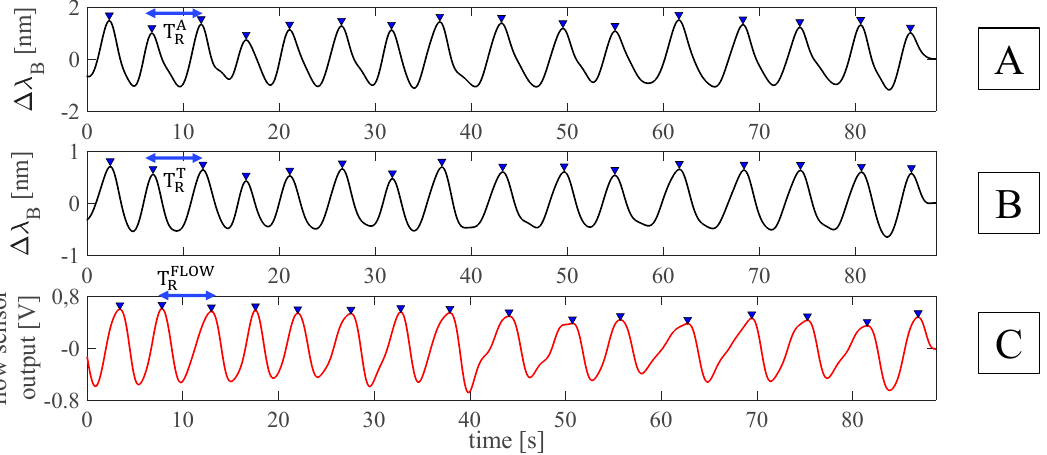
Figure 4. Outputs of the FBGs embedded into the smart textile and of the flow sensor during quiet breathing: ( A ) filtered output changes of FBG A ; ( B ) filtered output changes of FBG T ; ( C ) filtered output changes of the flow sensor. The respiratory periods for the band around the abdomen (i.e., T RA ), around the thorax (i.e., T RT ), and for the flow sensor (i.e., T RFLOW ) were also reported.